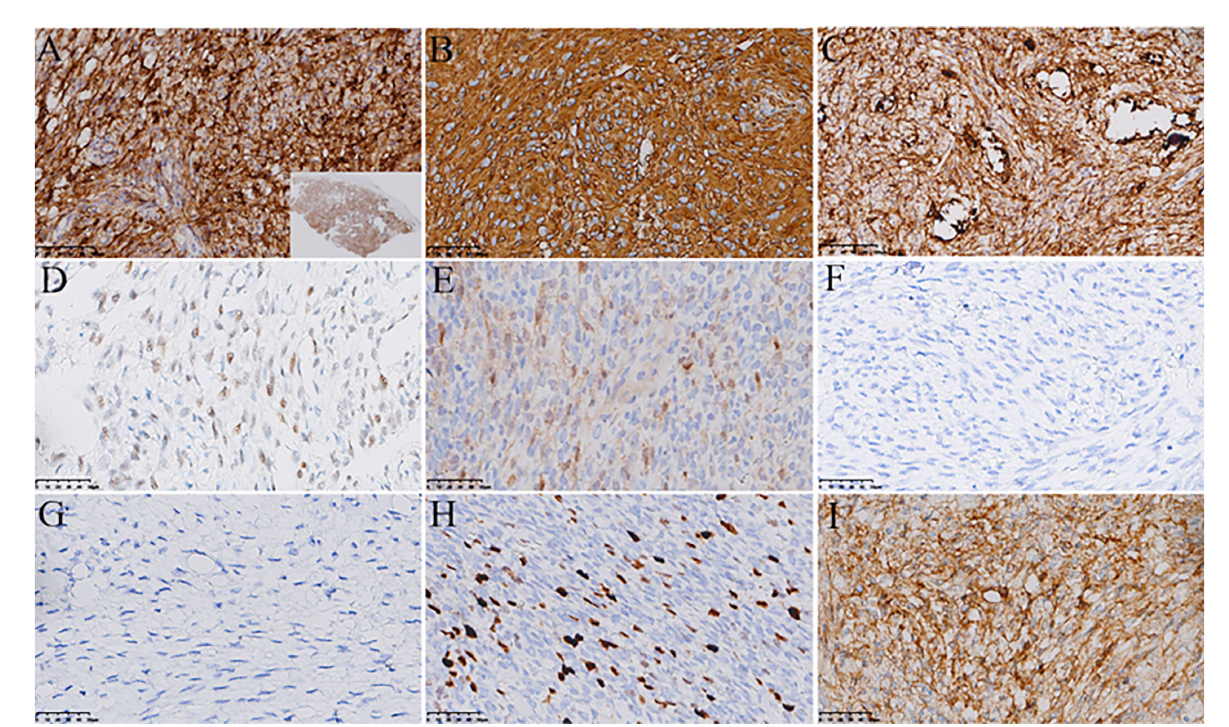
FIGURE 4 Immunohistochemistry. The tumor is diffusely and strongly positive for EMA (A) , scanning power is displayed in the lower right corner), vimentin (B) and SSTR2 (C) . The tumor is diffusely and weakly positive for PR (D) . The tumor is focally and weakly positive for S100 protein (E) . The tumor is negative for GFAP (F) , SOX-10 (G) , inhibin, CD34, STAT6, SMA, desmin, CKpan, D2-40, WT-1, CK5/6 and CD45. The highest proliferation index by Ki- 67 is 15% (H) , and the tumor cells express cytoplasmic ALK (I)